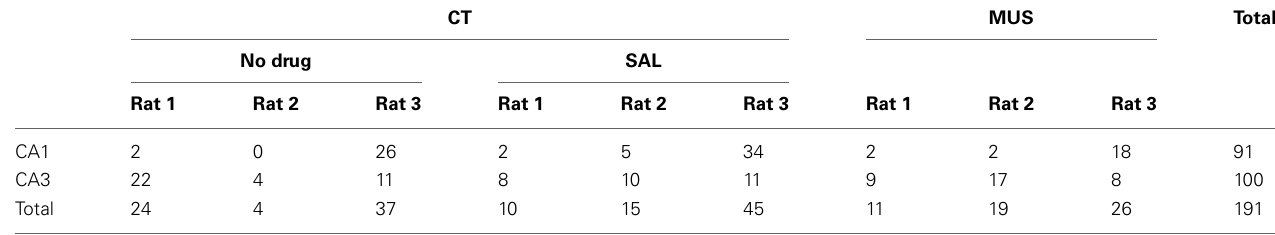
Table 1 | The number of units in CA1 and CA3 used in final analysis across different drug conditions in individual rats.